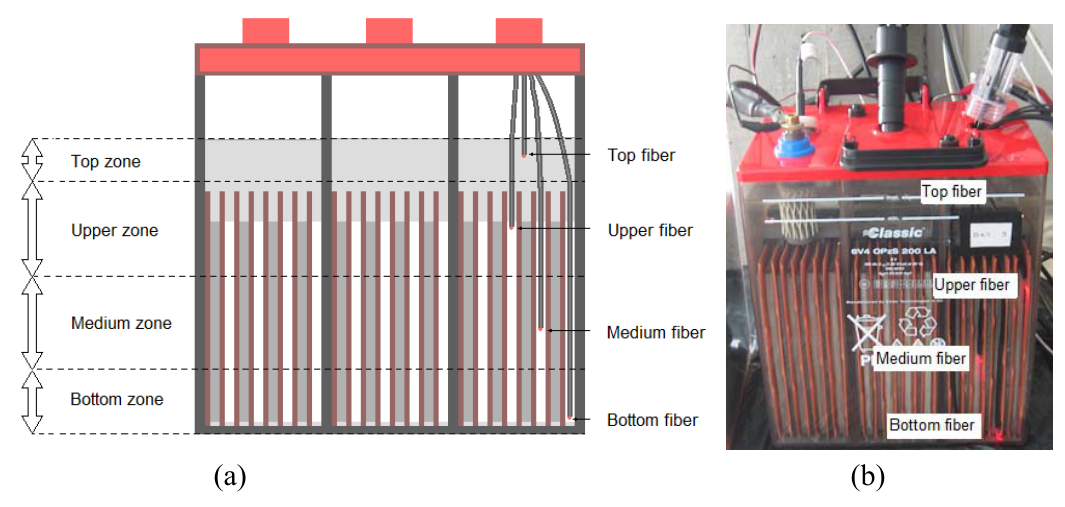
Figure 15. Multi-point sensor inside the battery. (a) Identification of different zones. (b) Photograph of the sensor located inside the cell.